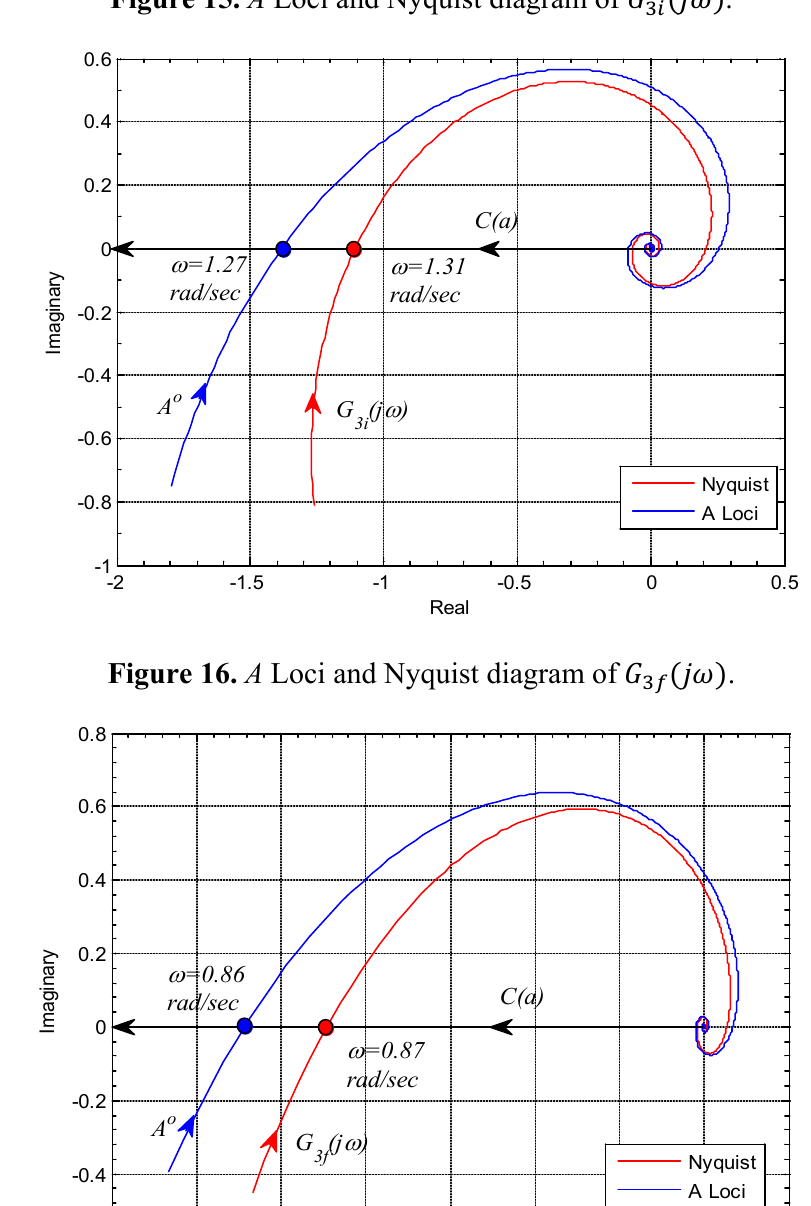
Figure 15. A Loci and Nyquist diagram of